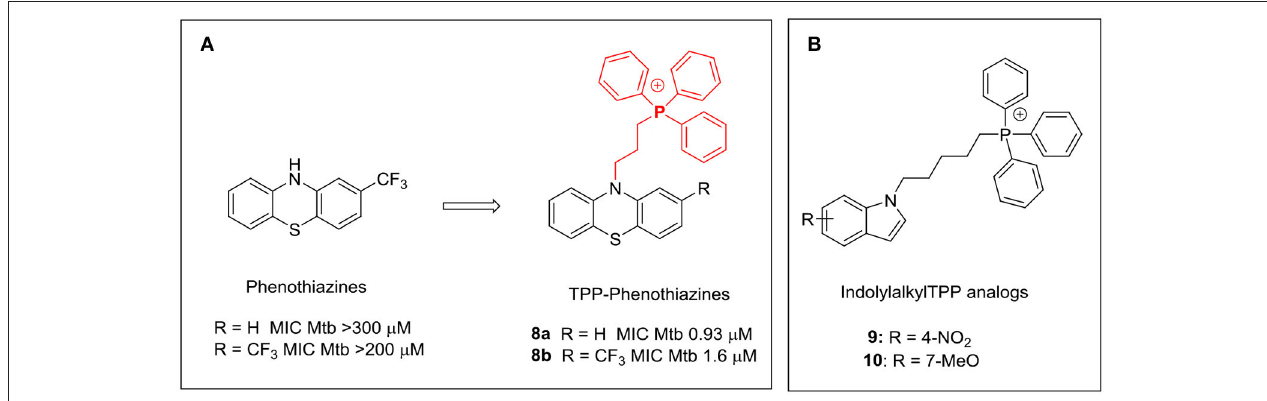
FIGURE 6 | (A) Attachment of a triphenylphosphonium side chain increased the antimycobacterial activity of phenothiazines 8a and 8b (Dunn et al., 2014); (B) Antimycobacterial TPP-indoles 9 and 10 with membrane targeting properties (Li et al.,